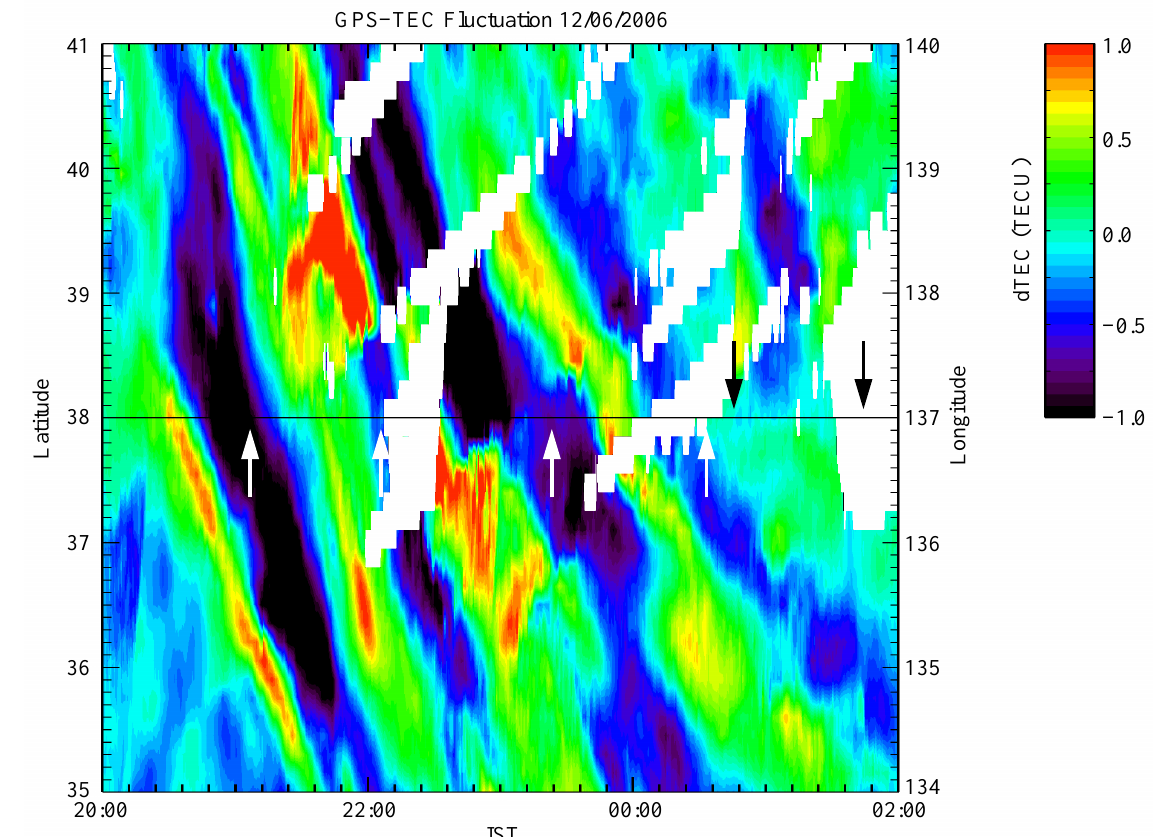
Fig. 8. TEC perturbation along the line from (35 ◦ N, 134 ◦ E) to (41 ◦ N, 140 ◦ E) (dashed line in Fig. 2 approximately perpendicular to the MSTID wavefront). Up and down arrows indicate the times when FAIs with positive and negative range rates, respectively, appeared in beam